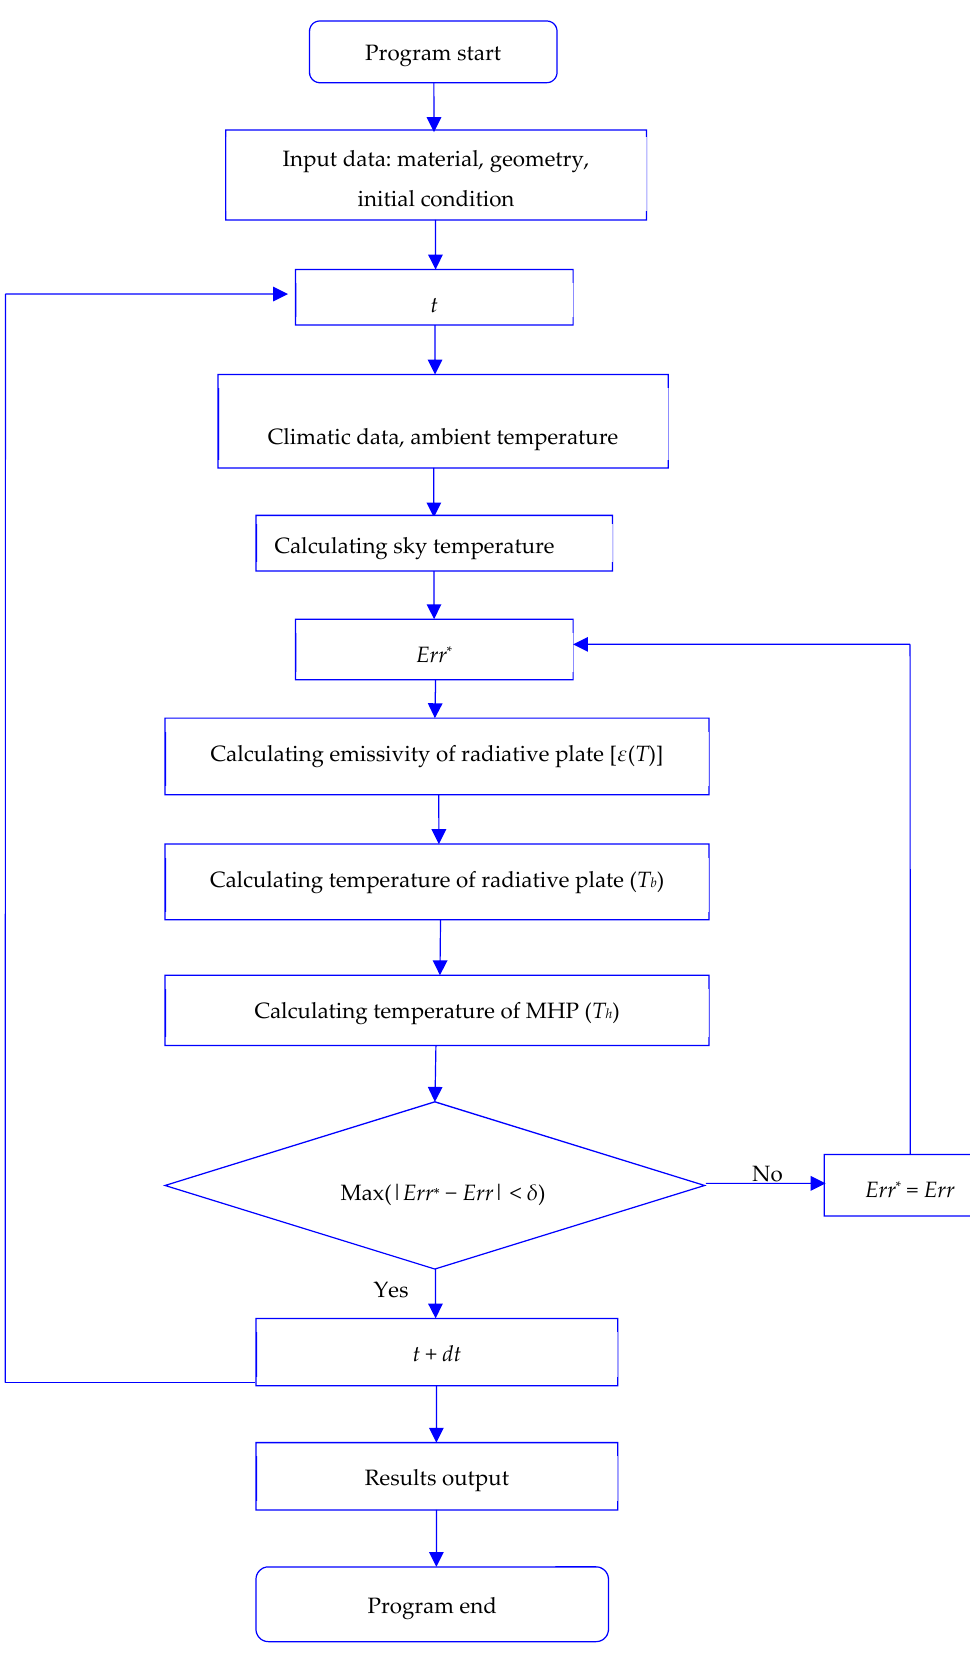
Figure 10. The calculated flow chart of dynamic mathematical model of the radiative plate.